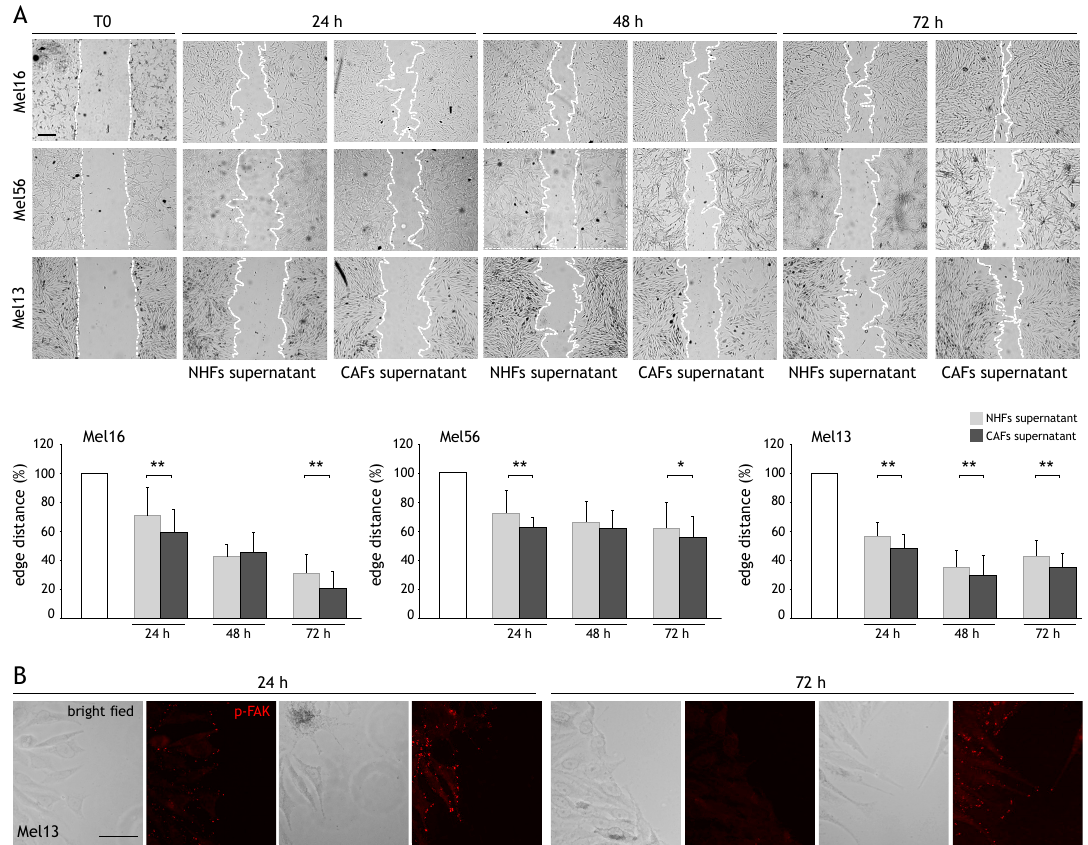
Figure 2. Effects of CAF supernatant on melanoma cell migration. ( A ) Representative images of the scratch wound assay of melanoma cells maintained in NHF and CAF supernatant at T0, 24, 48, and 72 h and quantitative analysis of the distance of the leading edge. Melanoma cell lines ( n = 3) were treated with the supernatant obtained from 1 sample of NHFs and 1 sample of CAFs. For each time point evaluated, the reduction of edge distance of melanoma cells treated with NHF supernatant was compared with that of the cells maintained with CAF supernatant. Scale bar: 200 µm. * p < 0.05 and ** p < 0.01 vs. NHF supernatant-treated cells. ( B ) Bright-field and immunofluorescence analysis of pFAK expression (red) in Mel13 melanoma cells grown in NHF ( n = 2) and CAF ( n = 2) supernatant for the indicated time points. Scale bar: 50 µm.